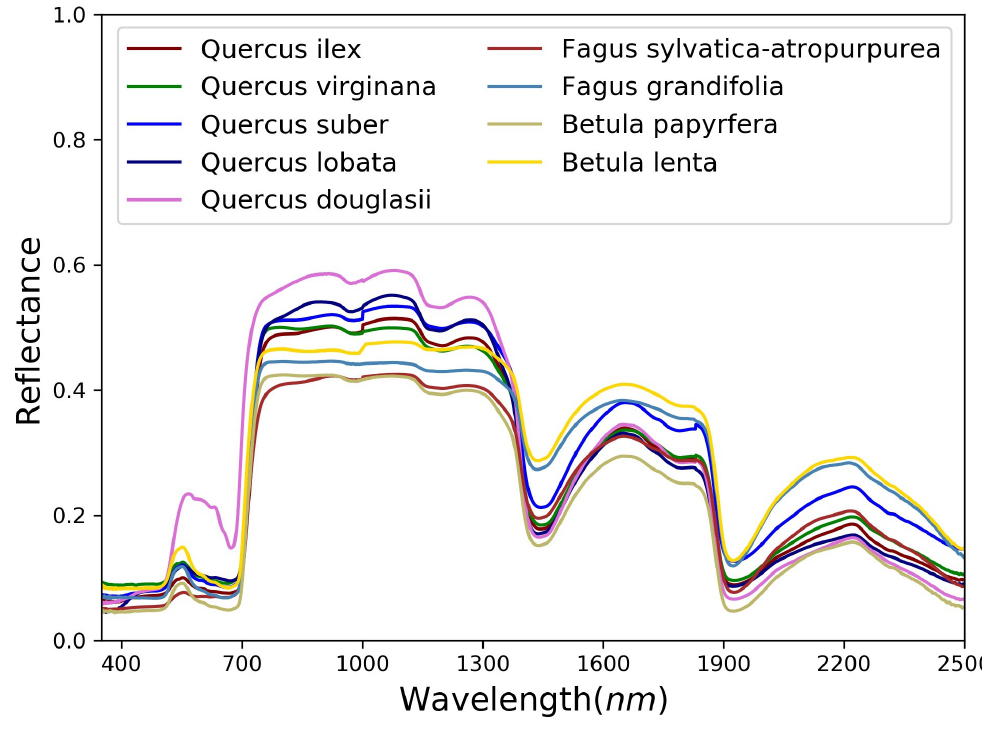
Figure 3. Spectral reflectance data selected from the ECOSTRESS Spectral Library used for the simulations. The main leaf genera are Quercus, Fagus, and Betula. In total, nine species of leaves were used. The wavelength interval is one